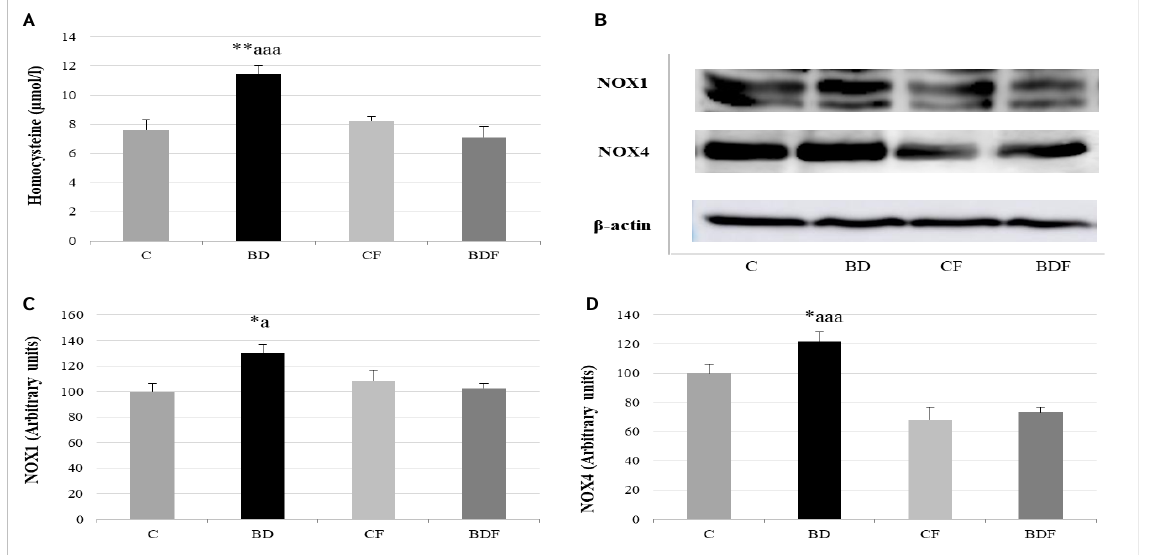
Figure 4. Study of serum homocysteine levels and their relationship with hepatic pro-oxidant enzymes NOX1 and NOX4. Homocysteine levels in serum ( A ). Representative Western blot for the expressions of NOX1, NOX4 and β -actin (as load control) ( B ). Expression of NOX in the liver of adolescent rats (expressed as percent arbitrary relative units, referring to values in control animals which were defined as 100%): NOX1 ( C ) and NOX4 ( D ). The results are expressed as mean ± SEM